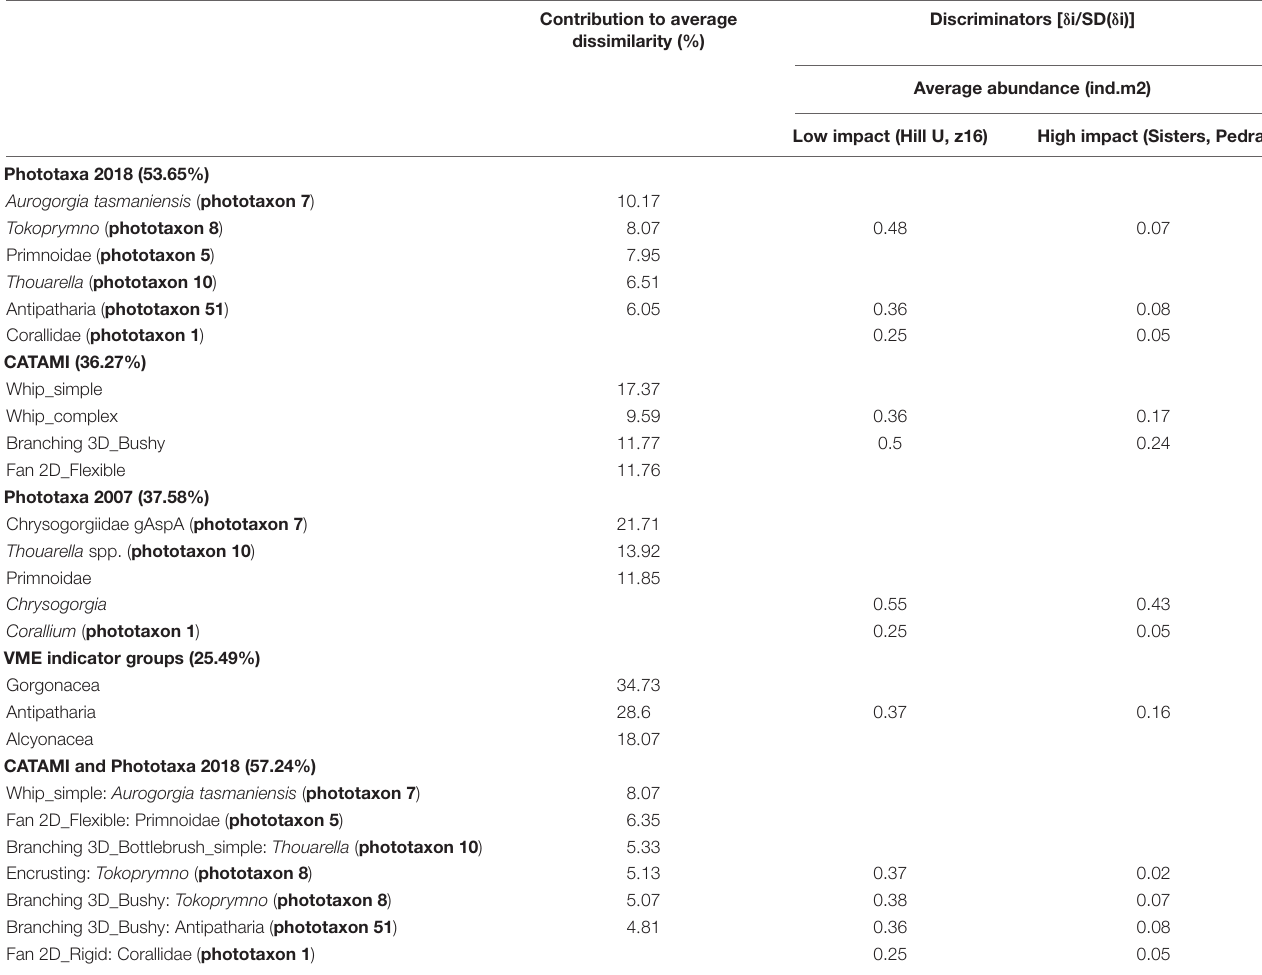
TABLE 5 | Results from SIMPER analysis of average dissimilarity between low impact (Hill U, z16) and high impact (Sisters, Pedra) seamounts detailing coral entities contributing most to average dissimilarity between groups of seamounts and the average abundance of discriminating entities. Contribution to average dissimilarity